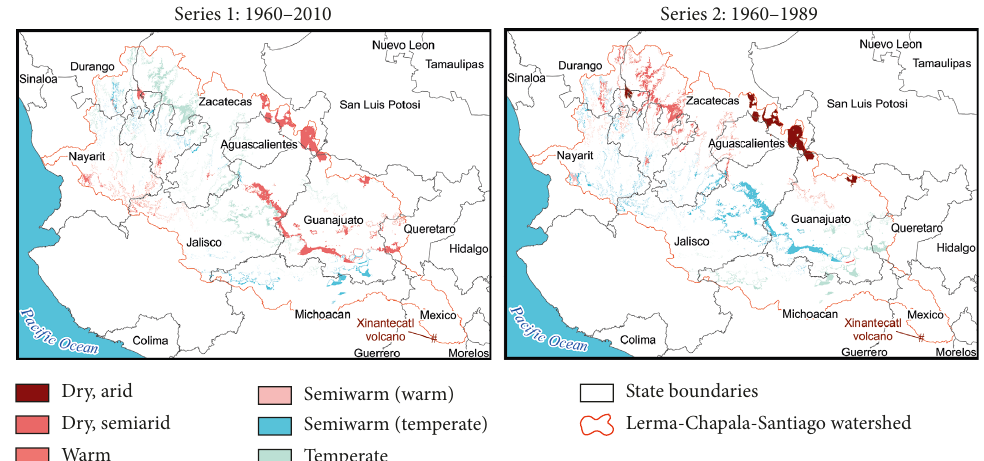
Figure 5: Areas of the watershed with changes in temperature conditions between time series one (1960–2010) and time series two (1960–1989). Table 1: Absolute, relative, and proportional areas of the Lerma-Chapala-Santiago watershed with changes in temperature between time series one (1960–2010) and time series two (1960–1989). No.